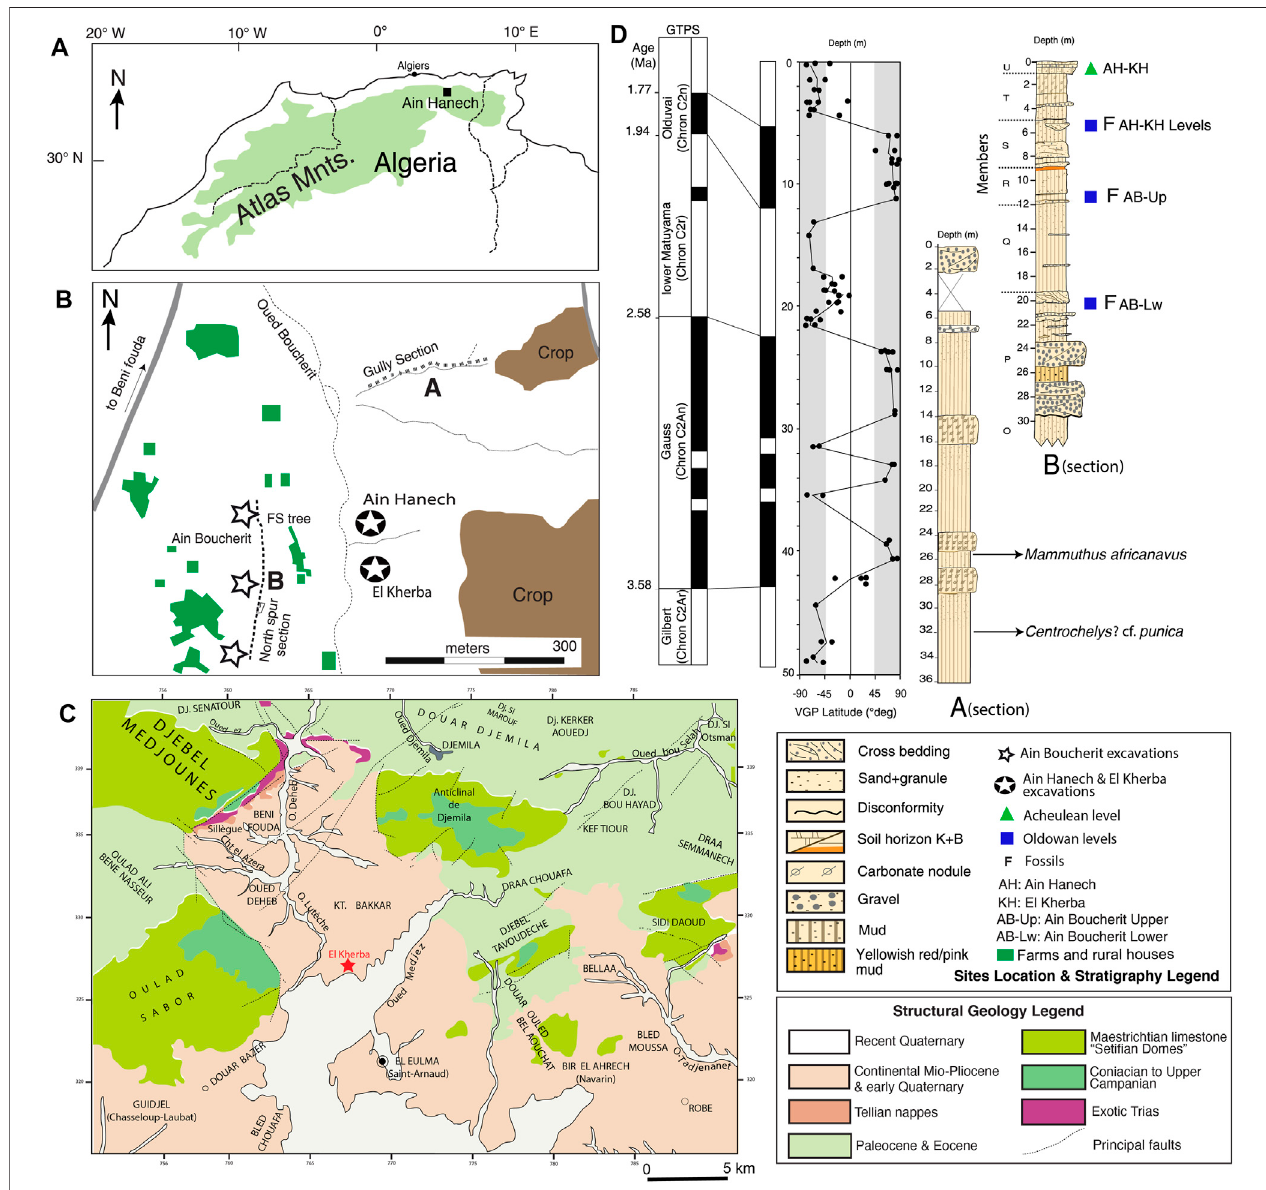
FIGURE 1 | Geography and geology of El Kherba, including (A) geographic situation of the Ain Hanech research area within Algeria, (B) situation of the El Kherba Oldowan site within the Ain Hanech research area, (C) El Kherba regional geological context (redrawn after El Eulma geological map, 1/50 000, 1977), and (D) stratigraphic and magnetostratigraphic position of El Kherba deposit within the Ain Hanech formation (modi fi ed after Sahnouni, 1998).